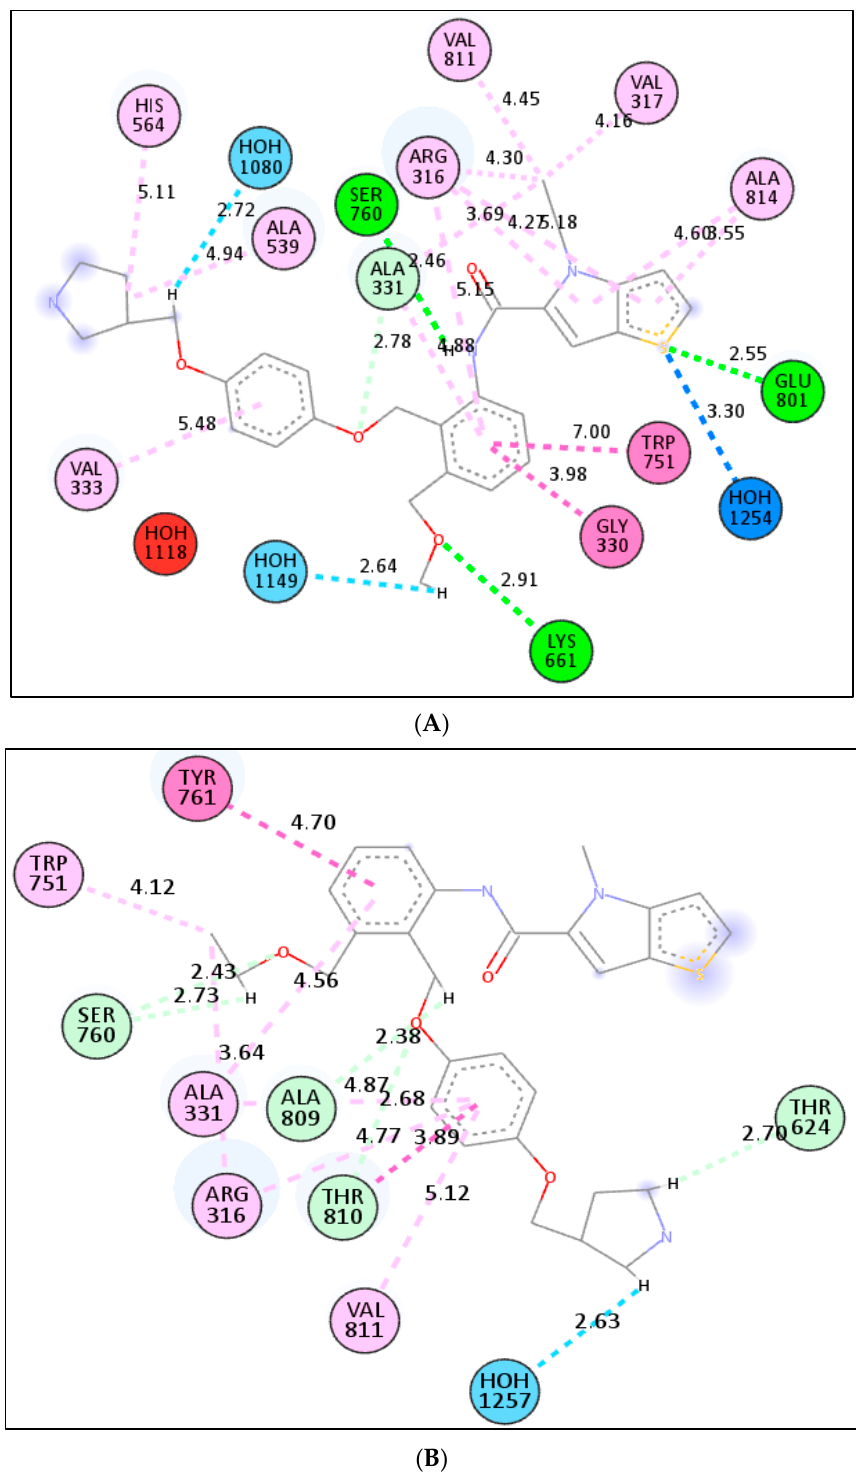
Figure 12. Presentation of the 2D and 3D interactions of compound 4 ( A ) and compound 1 ( B ) with LSD1 receptor.